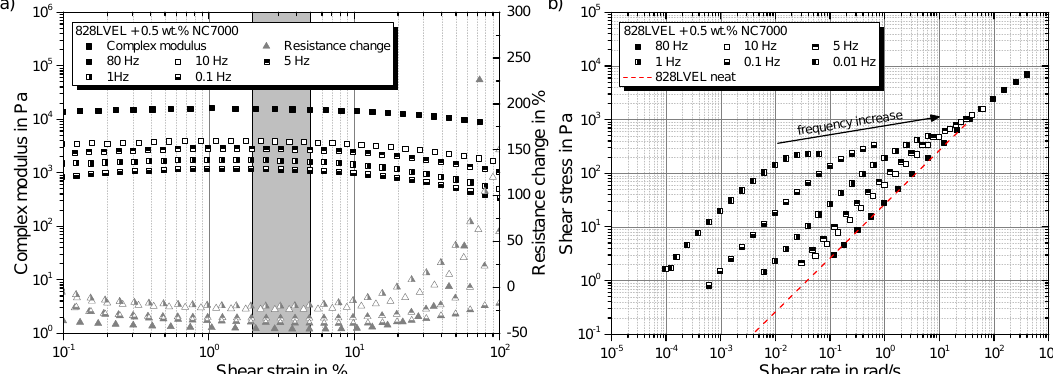
Figure 8. ( a ) Rheo-electrical material behavior in strain-sweeps at different frequencies; ( b ) shear stress in dependency of shear rate.